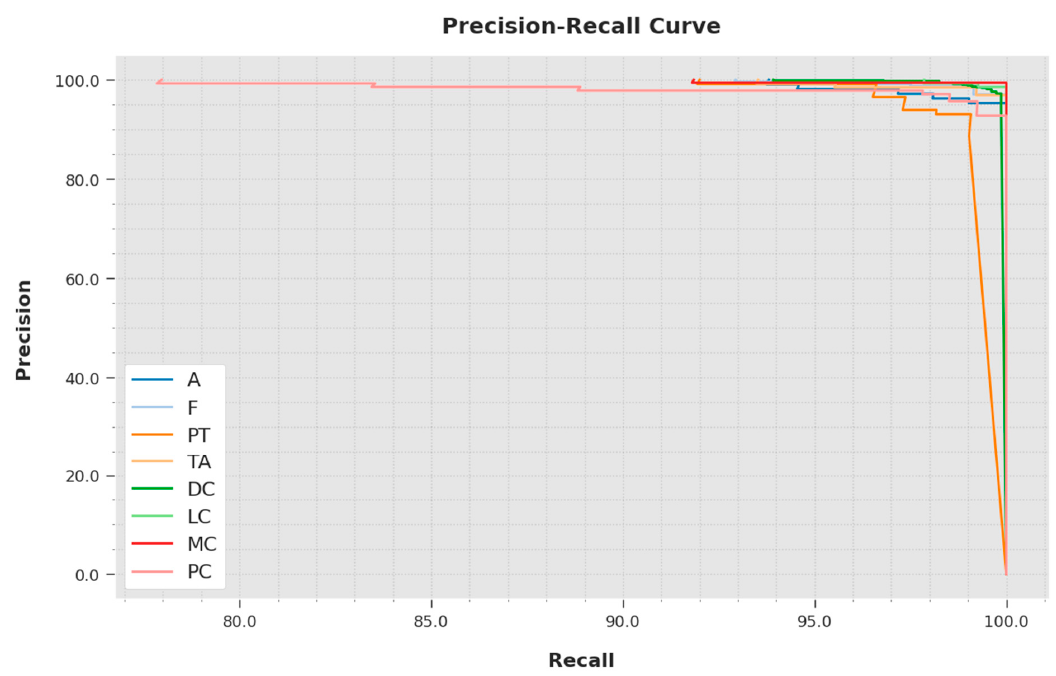
Figure 8. Precision-recall outcomes of the IBESSDL-BCHI approach.